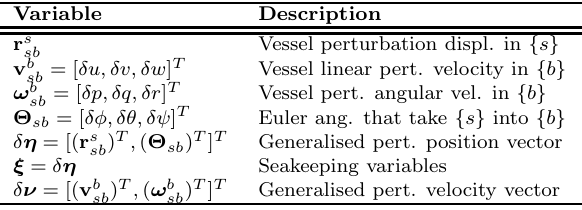
Table 3: Summary seakeeping vector